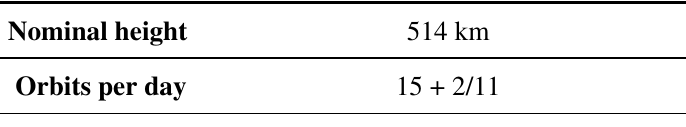
Table 3. PAZ orbit and incidence angle